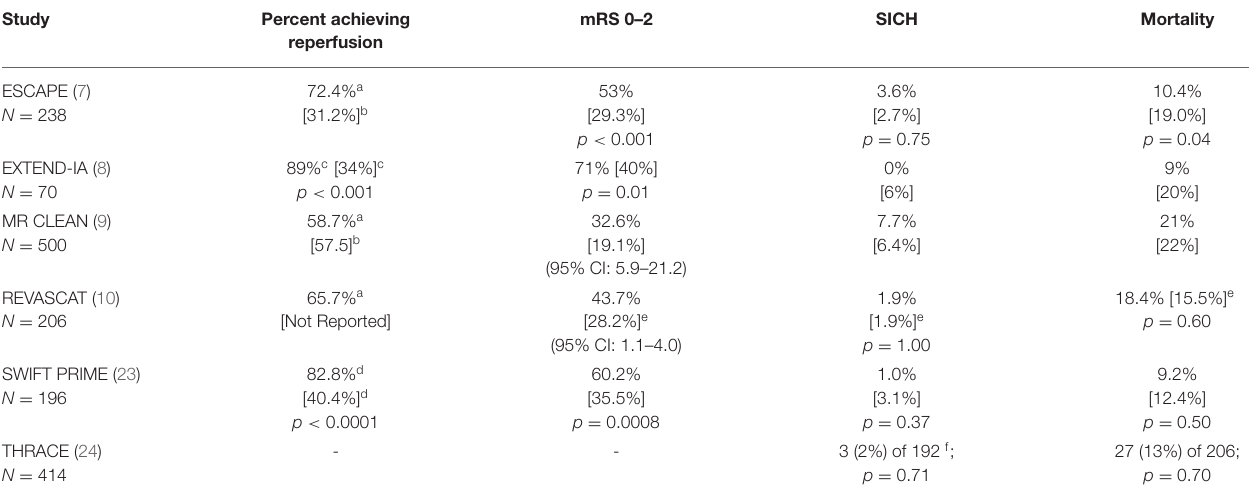
TABLE 1 | Summary of mechanical thrombectomy study outcomes. Study